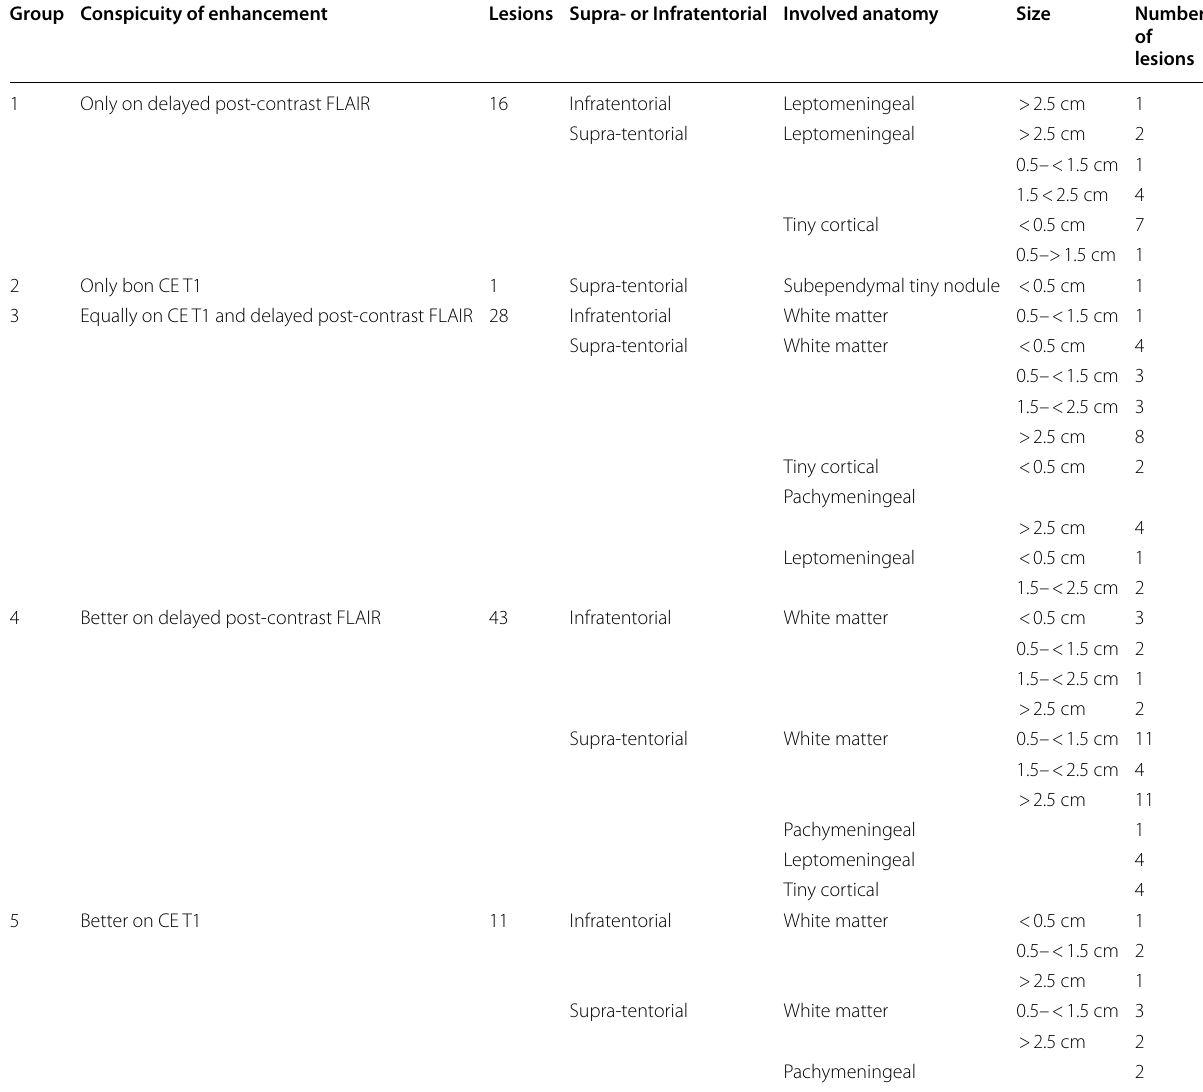
Table 1 Summary of the five groups classified according to lesion conspicuity detected by CE-T1WI and delayed post-contrast FLAIR Group Conspicuity of enhancement Lesions Supra- or Infratentorial Involved